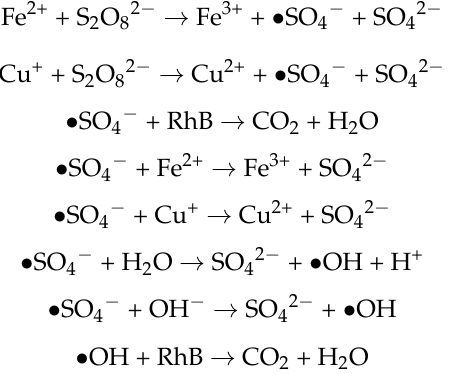
Figure 10. Fenton-like reaction for RhB degradation in the presence of Na 2 S 2 O 8 by using different catalysts: Cu 2 S (black), FeS 2 (red), and H-CuFeS 2 (blue).